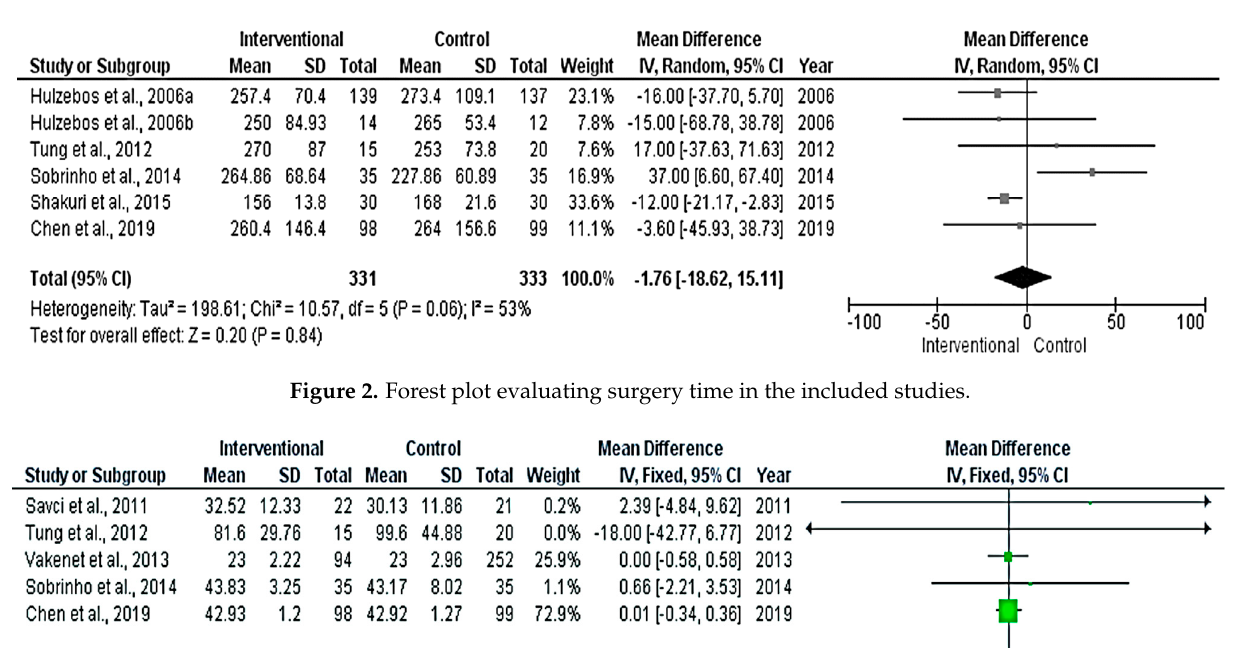
Figure 3. Forest plot evaluating ICU duration stay in the included studies.